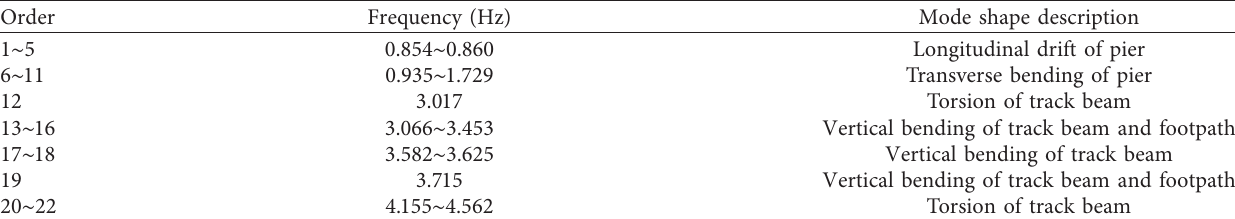
Table 1: Natural vibration characteristics of bridge structure.